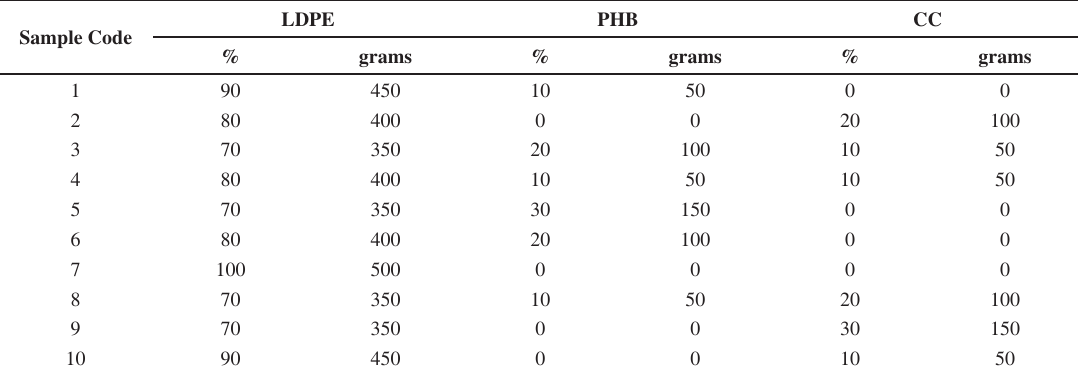
Table 3. Flexural Properties of LDPE and LDPE/PHB/CC Blends. Blends Flexural Modulus